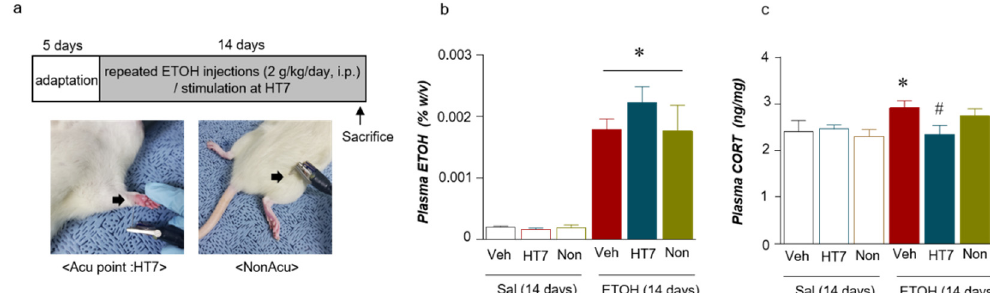
Figure 2. Schematic of the experimental procedure for repeated ETOH administration and representation of the mechanical acupuncture instrument (MAI) treatment ( a ). Plasma ETOH levels after acupuncture stimulation (n = 4–6 rats per group) ( b ). Plasma CORT levels (n = 7–9 rats per group) ( c ). The data were analyzed using repeated measures one- and two-way ANOVA and t-tests. * p < 0.05 compared with the Sal + Veh group and # p < 0.05 compared with the ETOH + Veh group. Values are presented as means ±